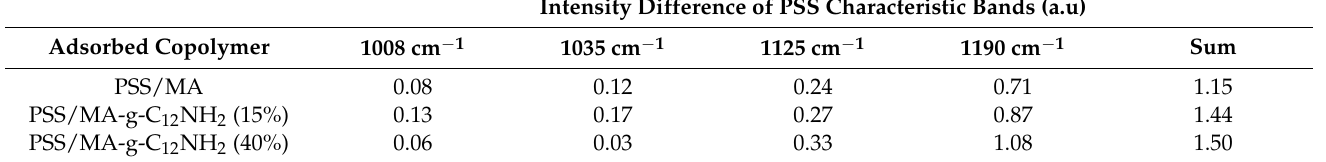
Table 3. The intensity difference of the PSS characteristic bands for adsorbed non-modified and modified PSS/MA copolymer as the top layer of the multilayer film. Intensity Difference of PSS Characteristic Bands